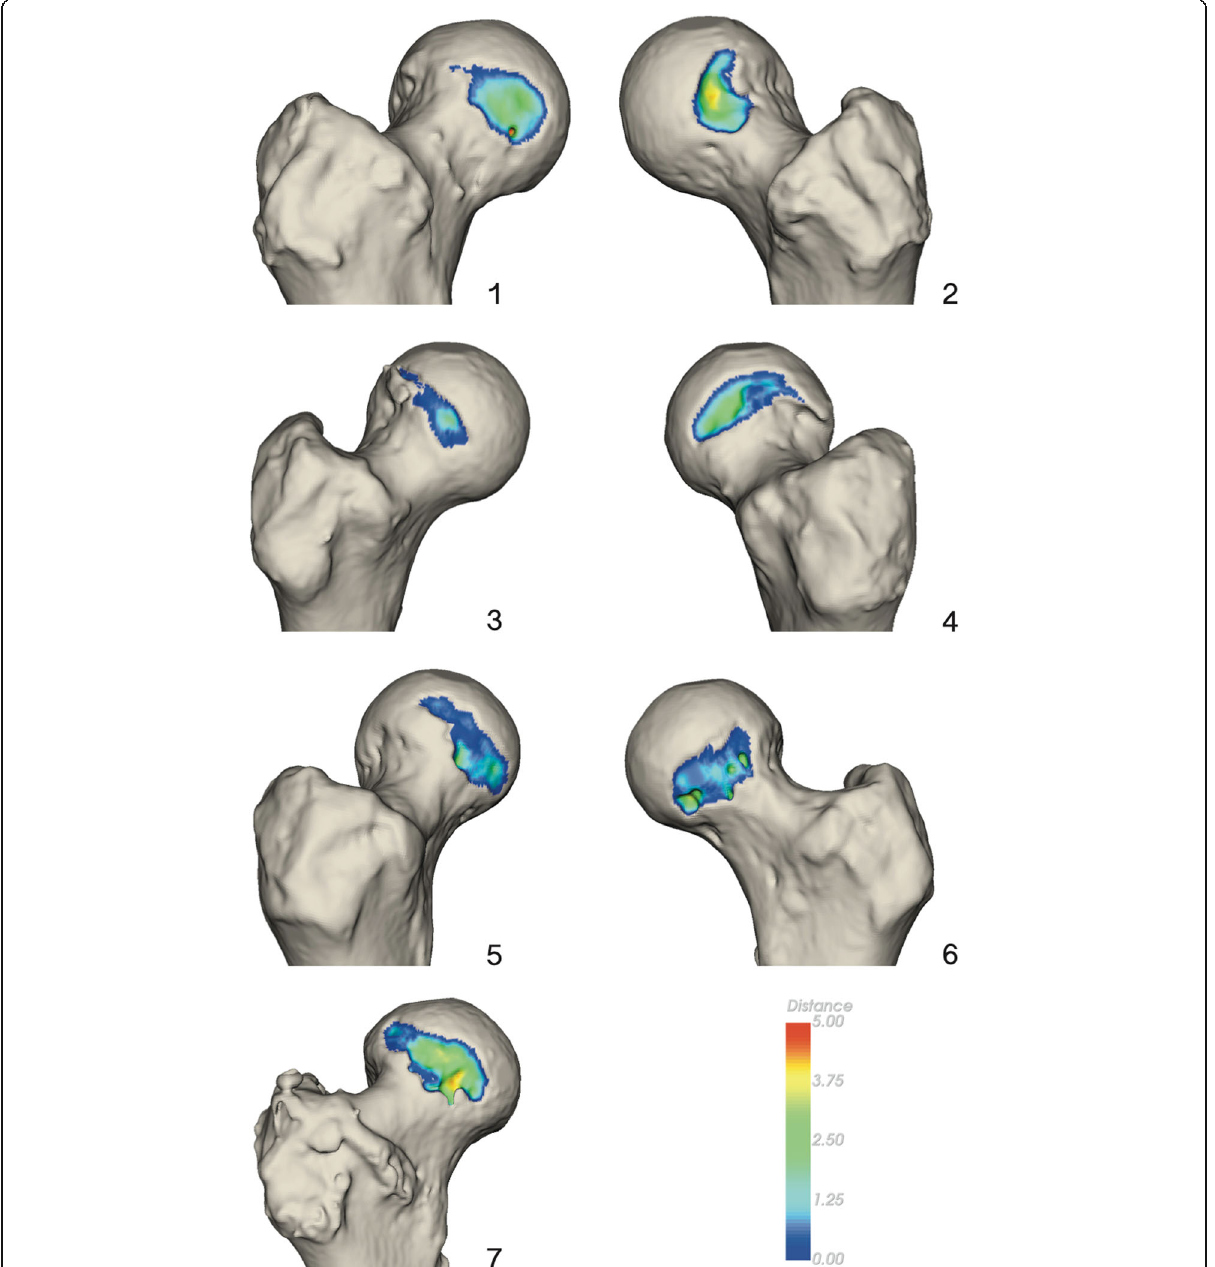
Fig. 5 Figure showing the area and depth of resected bone during ACH for all seven donor hips. The color scale refers to depth of